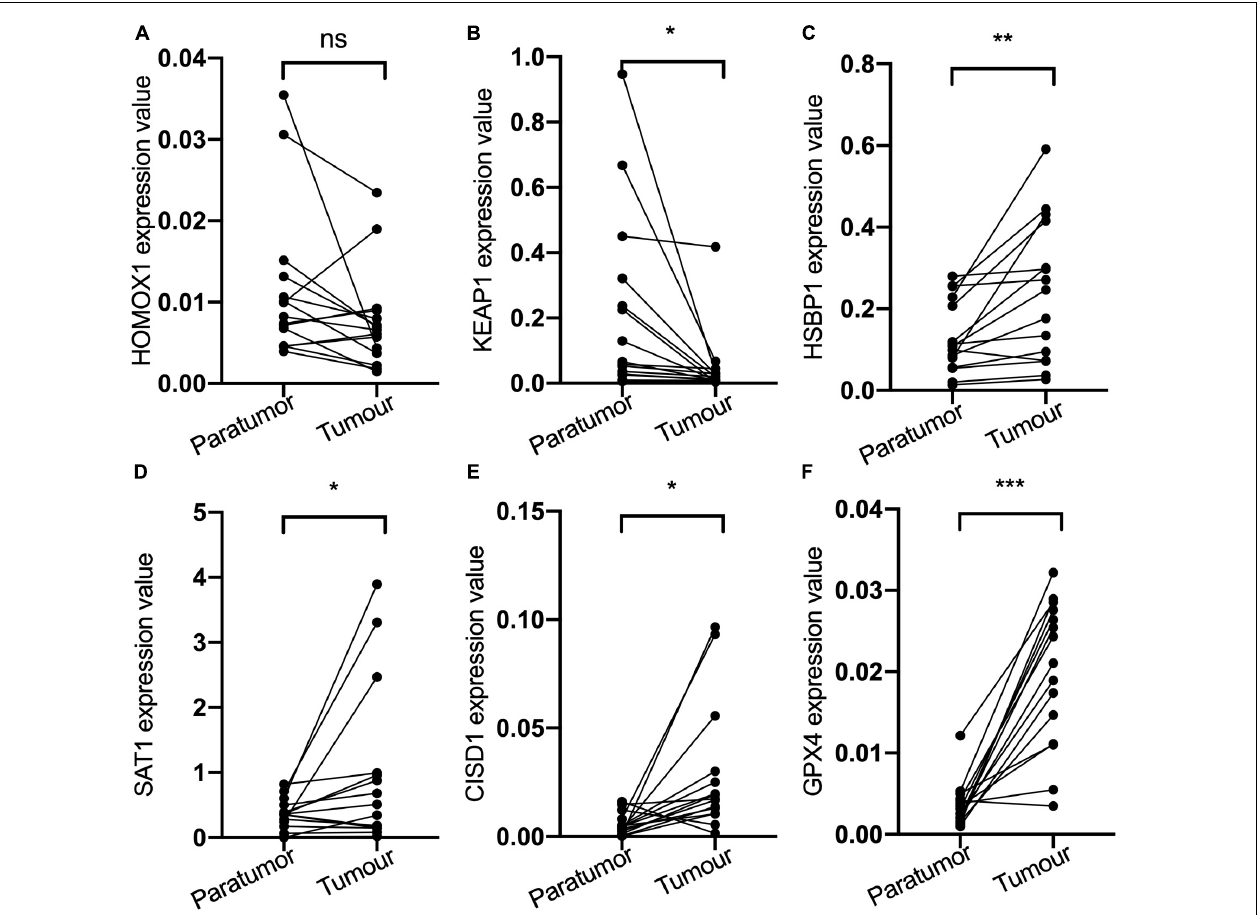
FIGURE 2 | (A) HOMOX1 expression level. (B) KEAP1 expression level. (C) HSBP1 expression level. (D) SAT1 expression level. (E) CIDS1 expression level. (F) GPX4 expression level. ns, not significant, * P < 0.05, ** P < 0.01, *** P < 0.001.